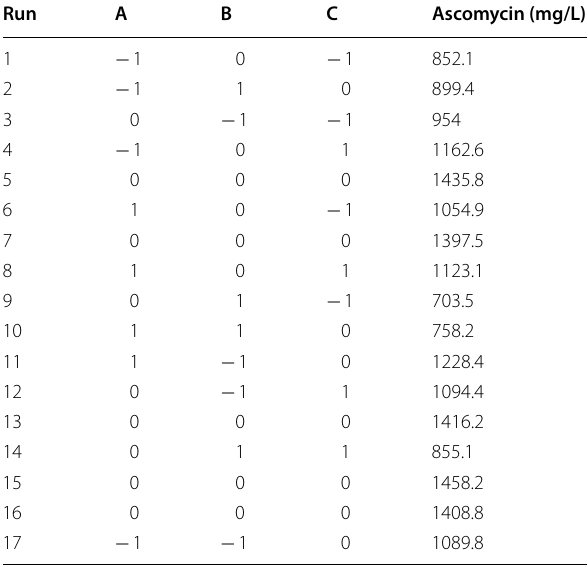
Table 2 Experimental design for media